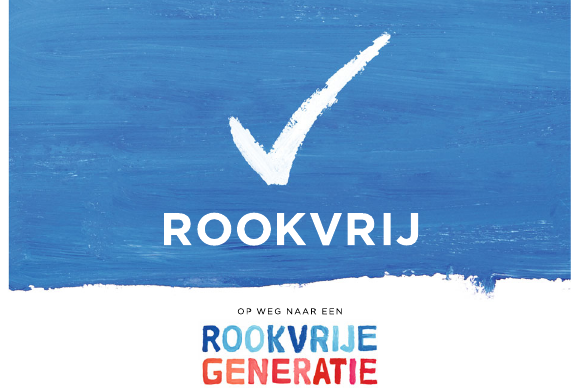
Fig. 3 Smoke-free Generation sign. Uniform design of a sign to depict an indoor or outdoor area as smoke-free. Translation: ‘ Smoke-free; Moving towards a Smoke-free Generation ’ . ‘ Health Funds for Smoke-free ’ ( Gezondheidsfondsen voor Rookvrij ; GvRV); reprinted with